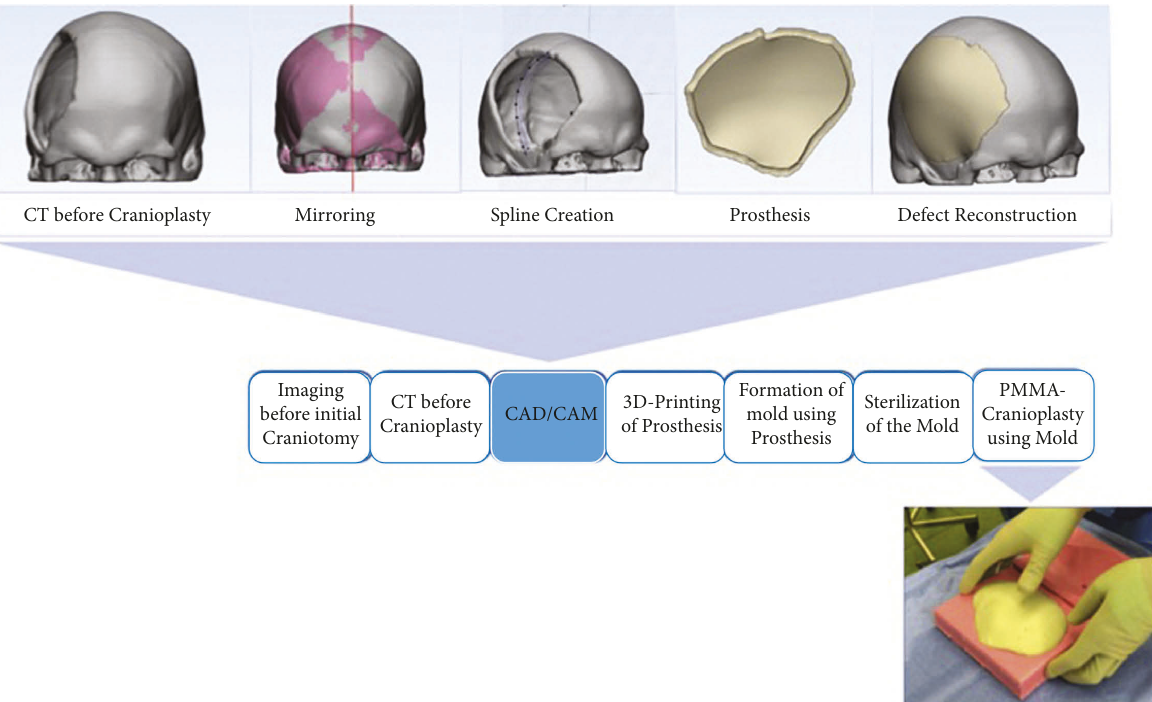
Figure 5: Workflow of the production of implantable patient-specific PMMA implants. The upper row shows the CAD/CAM (computer- assisted design/computer-assisted manufacturing) of the prosthesis that is printed out using a 3D printer. The prosthesis is then used to form the heat-resistant silicone mold, which is sterilized and intraoperatively used to form the patient-specific PMMA implant. 3D, three- dimensional; CT, computed tomography; PMMA, polymethyl methacrylate; reprinted with permission under open access by Sch¨on et al. [76].